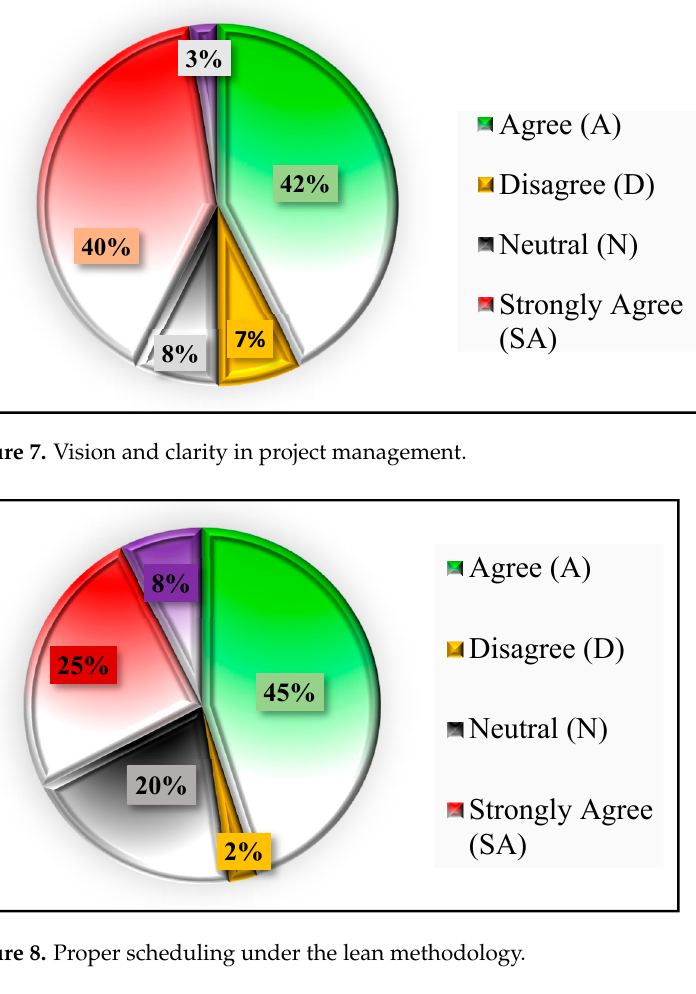
Figure 8. Proper scheduling under the lean methodology .